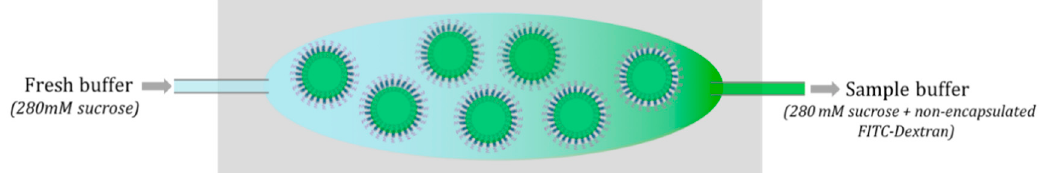
Figure 2. Top-down schematic for buffer exchange procedure. Buffer exchange is required for removal of non-encapsulated aqueous molecules. Fluorescein isothiocyanate-dextran (FITC-dextran) is included in the hydration buffer for encapsulation within the polymersome core. Excess FITC-dextran which remains in the buffer must be removed in order to facilitate imaging of the polymersome core.